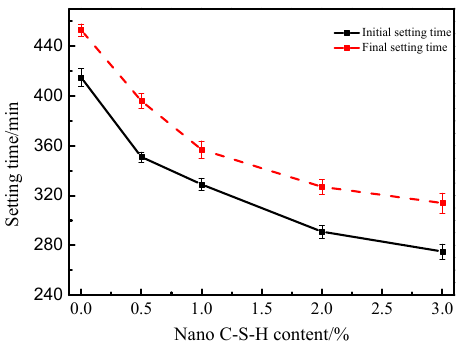
Figure 3. The initial and final setting times of cement paste with di ff erent contents of nano Figure 3 . The initial and final setting times of cement paste with different contents of nano C-S-H C-S-H particles. particles.